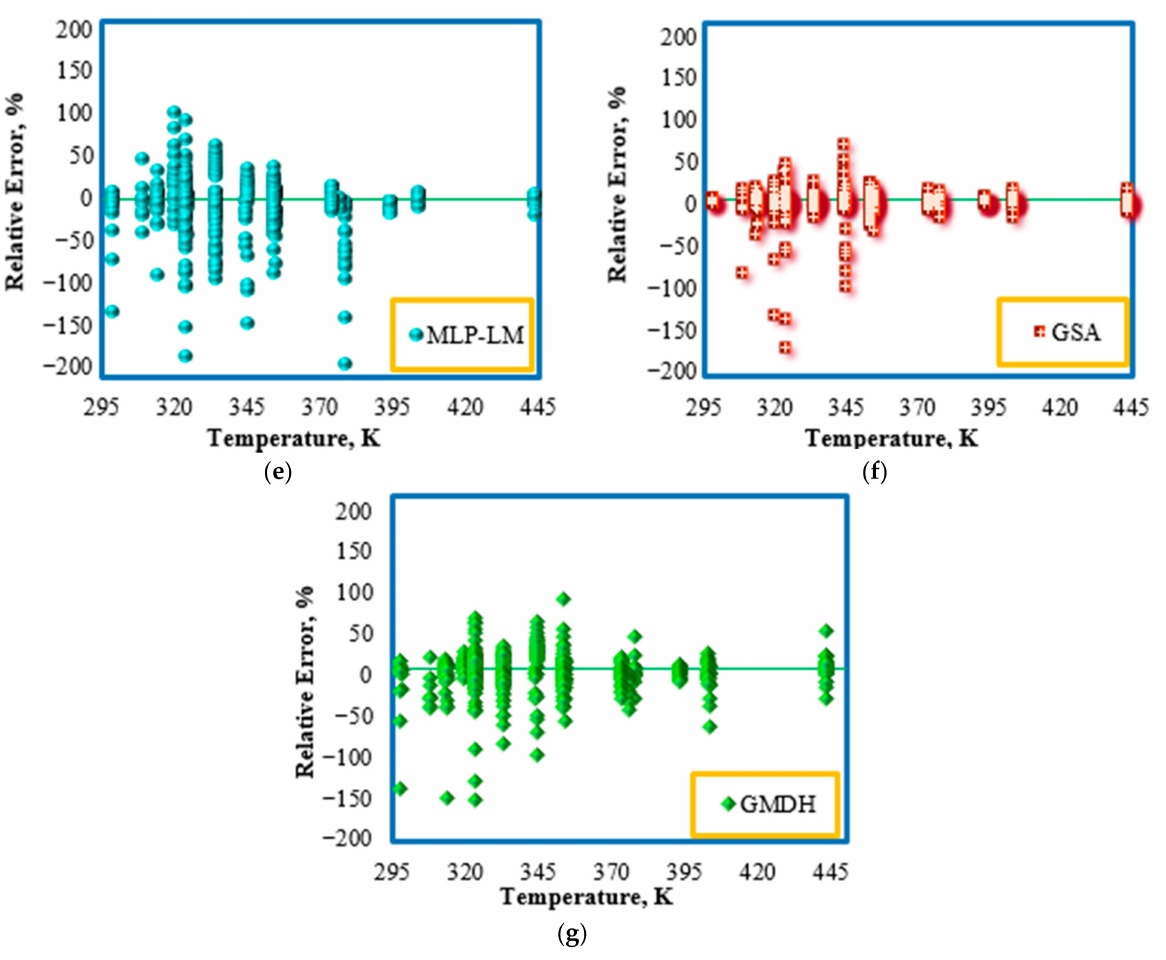
Figure 5. Error distributions corresponding to the developed models to obtain IFT as a function of temperature (K): ( a ) RBF-ICA, ( b ) RBF-ACO, ( c ) RBF-GA, ( d ) RBF-PSO, ( e ) RBF-GSA, ( f ) MLP-LM, and ( g ) GMDH